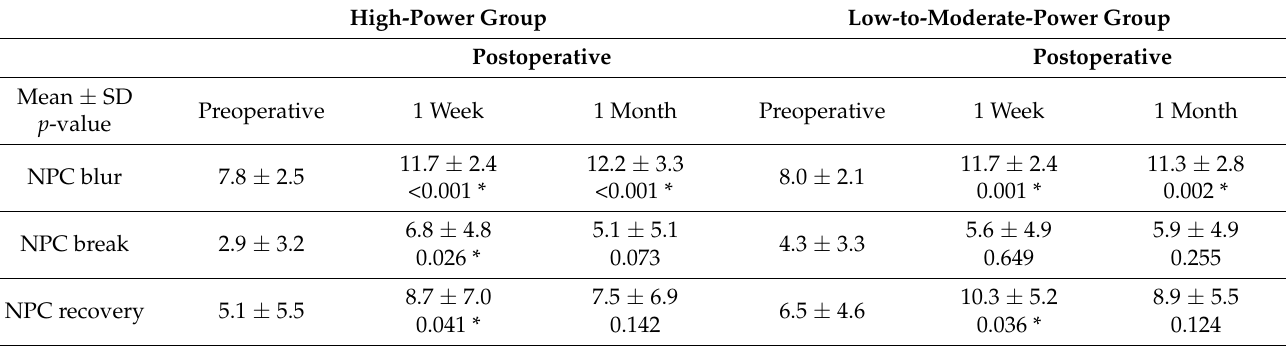
Table 4. Near point of convergence: blur, break, and recovery values (cm) for high- and low-to- moderate-power group at one week and one month after surgery. High-Power Group Low-to-Moderate-Power Group Postoperative Postoperative Mean ± SD Preoperative 1 Week 1 Month Preoperative 1 Week 1 p -value